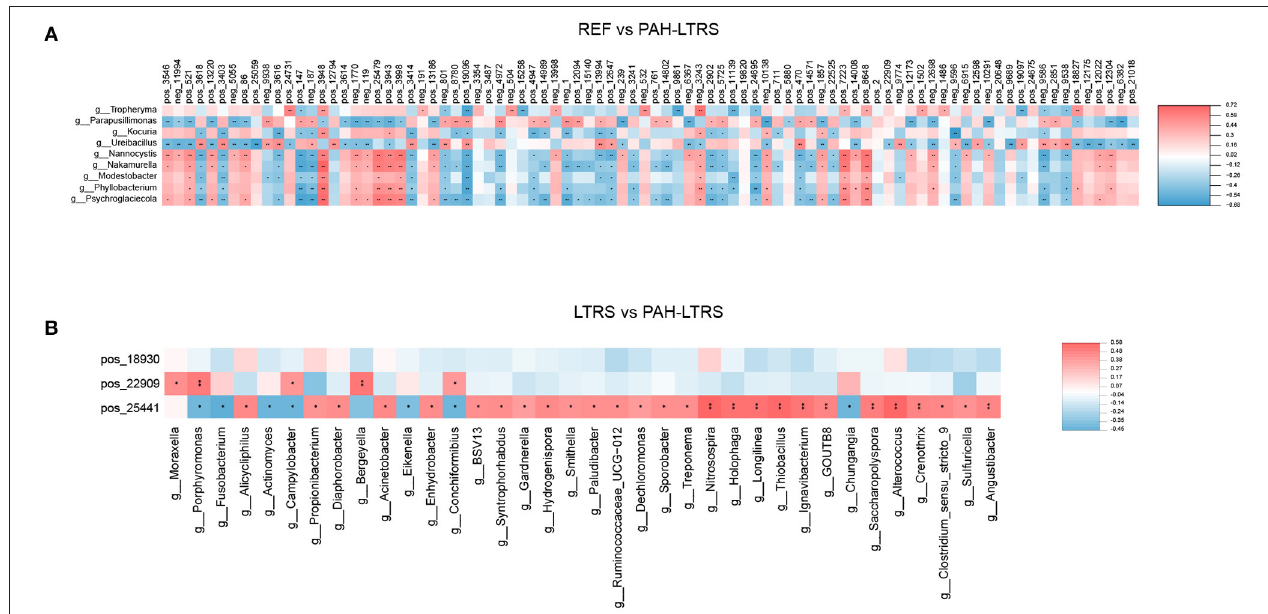
FIGURE 6 | Significant correlation between lung bacteria and differential metabolites. Heatmap indicated positive (red) and negative (blue) correlations between metabolites and the microbiota at the genus level detected in REF compared with PAH-LTRS cohort (A) and LTRS compared with PAH-LTRS cohort (B) . The legend shows correlation values from − 1 to 1. *Represents significantly negative or positive correlations (* P < 0.05, ** P < 0.01). PAH-LTRS, patients with pulmonary arterial hypertension associated with Left-to-Right shunt ( n = 19); REF, healthy reference ( n = 20); LTRS, patients with Left-to-Right shunts but without PAH ( n =